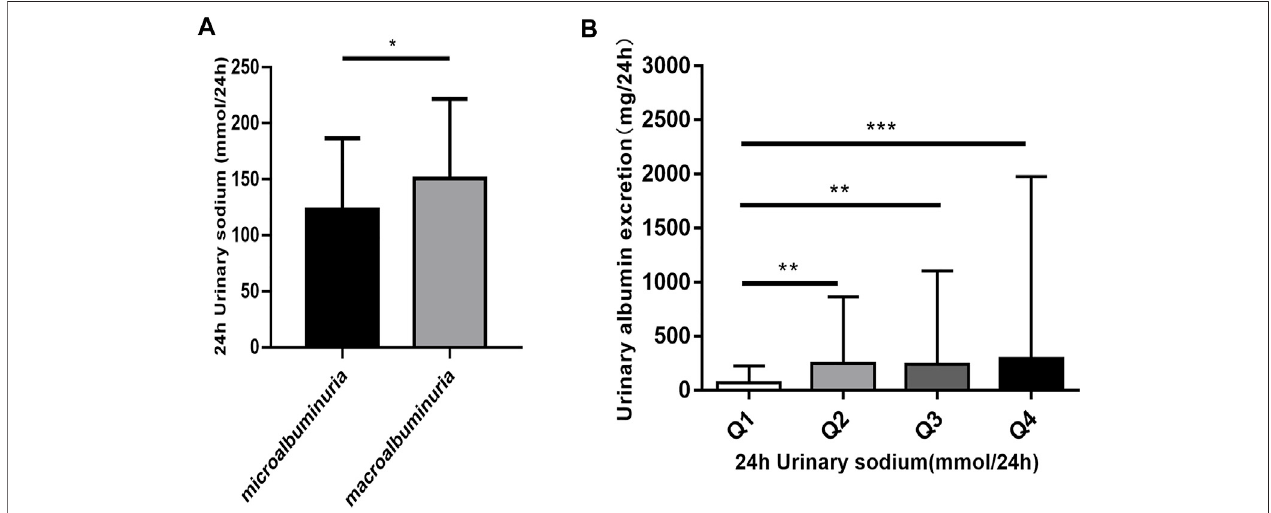
FIGURE 1 | The relationship of 24 h urinary sodium excretion and 24 h urinary albumin excretion. (A) Patients were classi fi ed according to the urinary albumin excretion. The data are mean ± SD. * p < 0.05 vs. microalbuminuria group. (B) The patients were divided into four groups according to 24 h urinary sodium excretion. Quartile 1 (Q1) refers to the lowest sodium excretion quartile, and quartile 4 (Q4) indicates the highest sodium excretion quartile. The data are mean ± IQR. ** p (cid:1) 0.001 and *** p (cid:1) 0.000 vs. Q1 group.